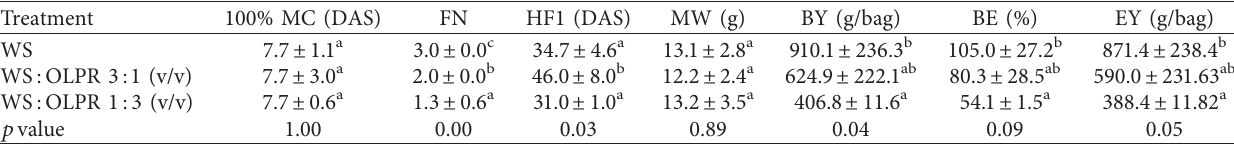
Table 2: Substrate effect on various parameters of mushroom growth and production.